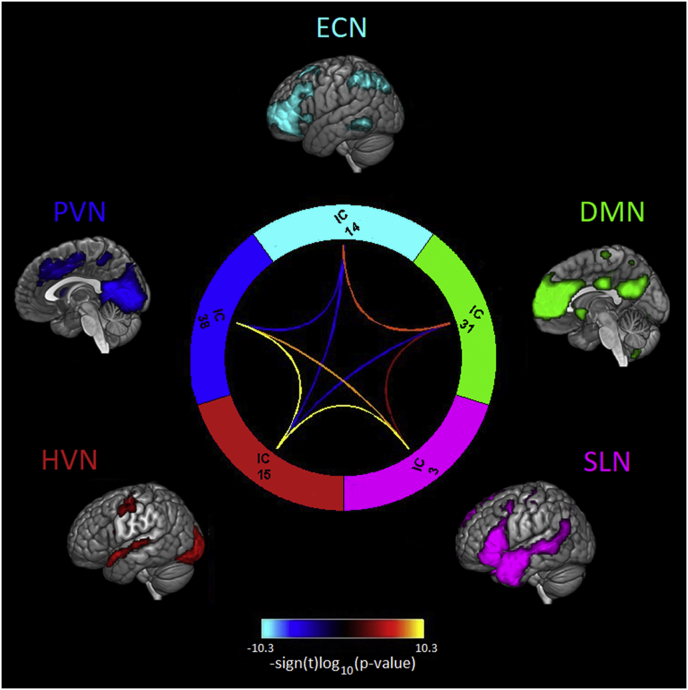
FNC results. Connectogram of the FNC results: Significant pairwise correlations (p ​< ​0.05) were corrected for multiple comparisons (FDR, α ​= ​0.01). Significance and direction of each pairwise correlation is displayed as the −sign(t)log10(p).